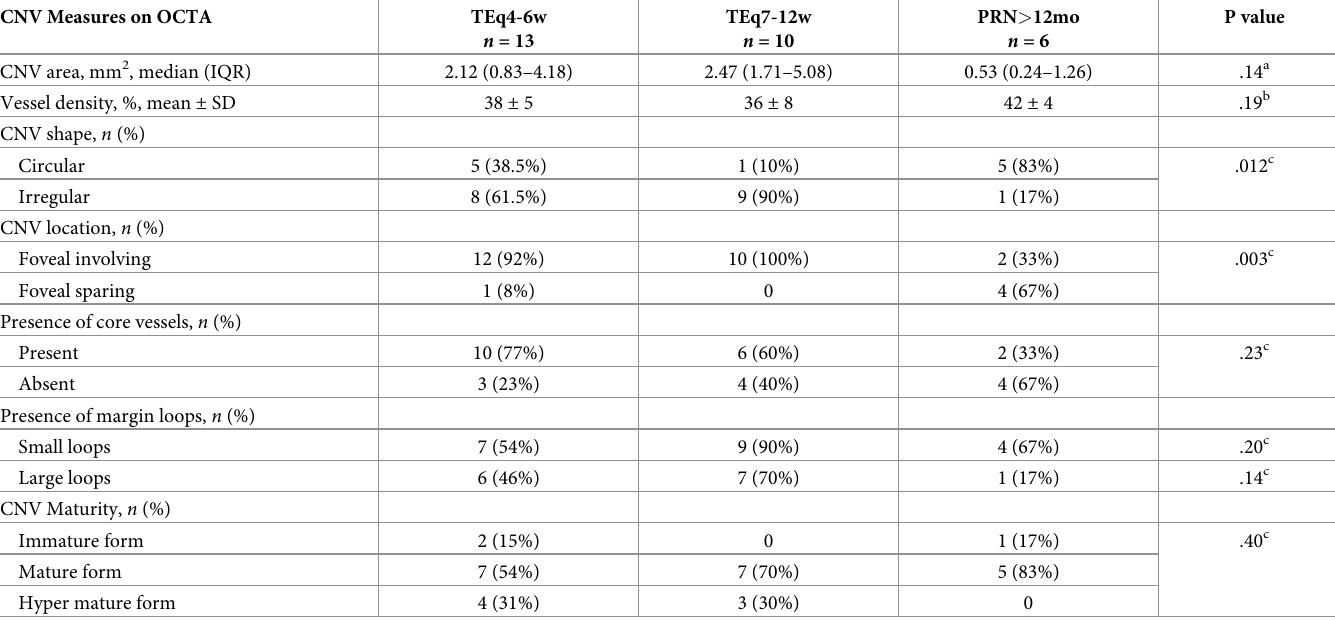
Table 2. Characteristics of CNV on OCTA by analysis